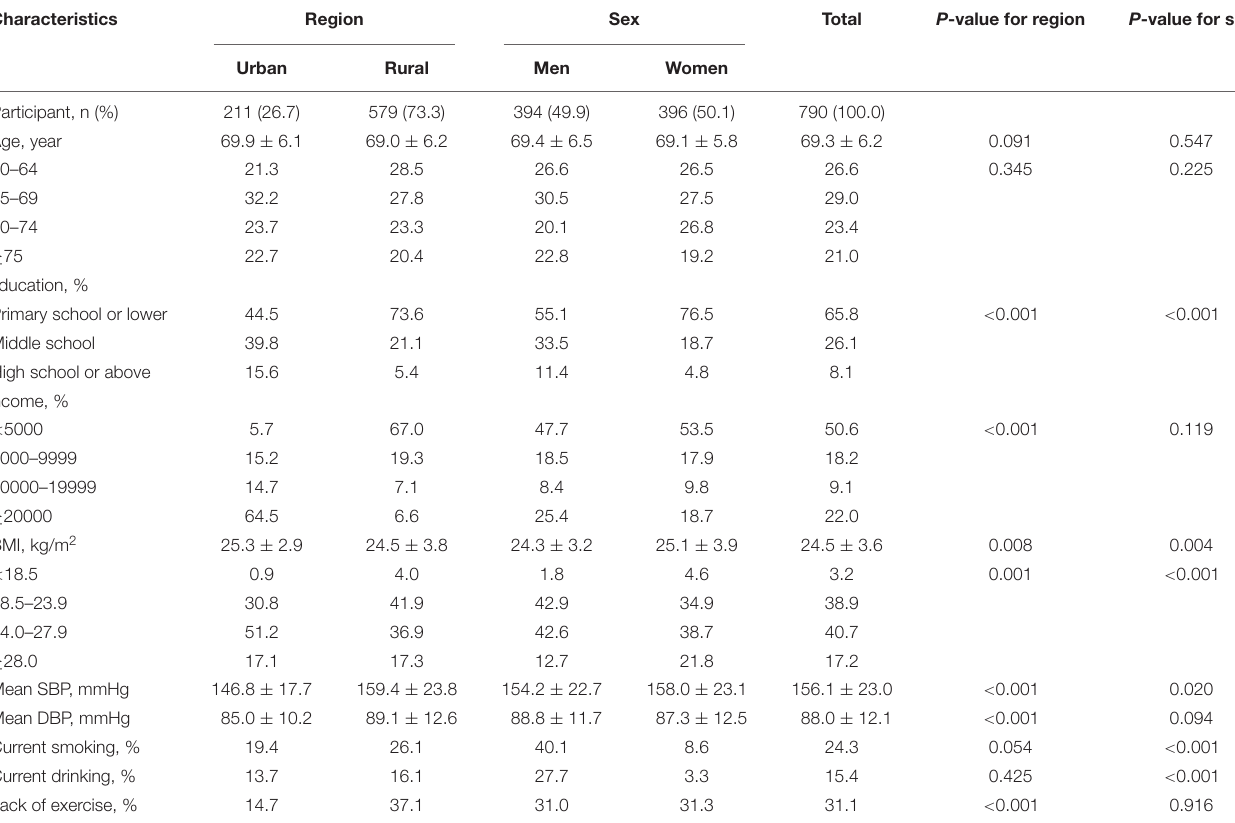
TABLE 1 | Characteristics of the study participants ( ≥ 60 years). Characteristics Region P -value for sex